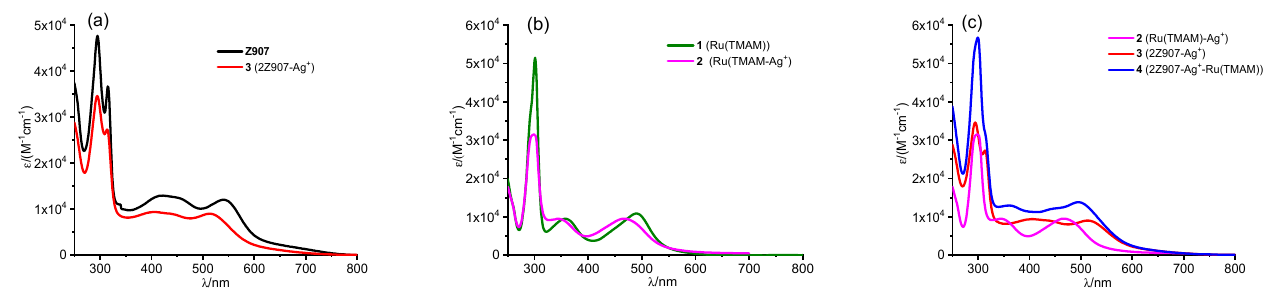
Figure 3. Comparison between absorption spectra of: ( a ) Z907 (black line) and 3 (2Z907-Ag + ) (red line), ( b ) 1 (Ru(TMAM)) (green line) and 2 (Ru(TMAM)-Ag + ) (purple line) and ( c ) between 2 (purple line), 3 (red line) and 4 (2Z907-Ag + -Ru(TMAM)) (blue